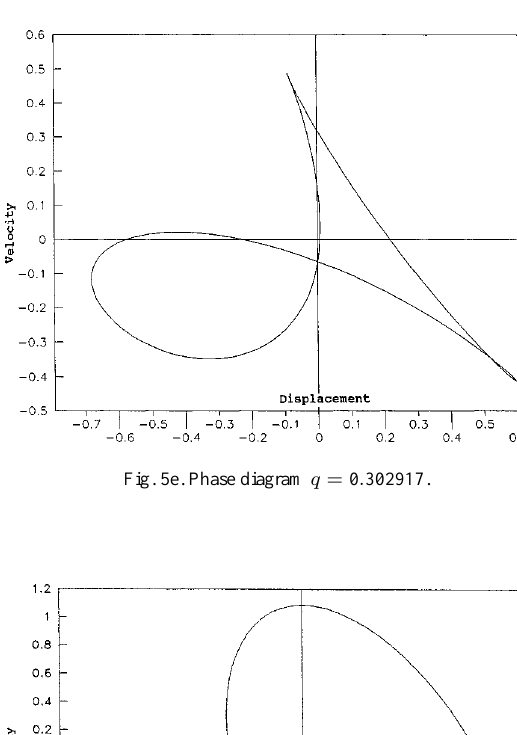
Fig. 5d. Phase diagram q = 0 : 287361.